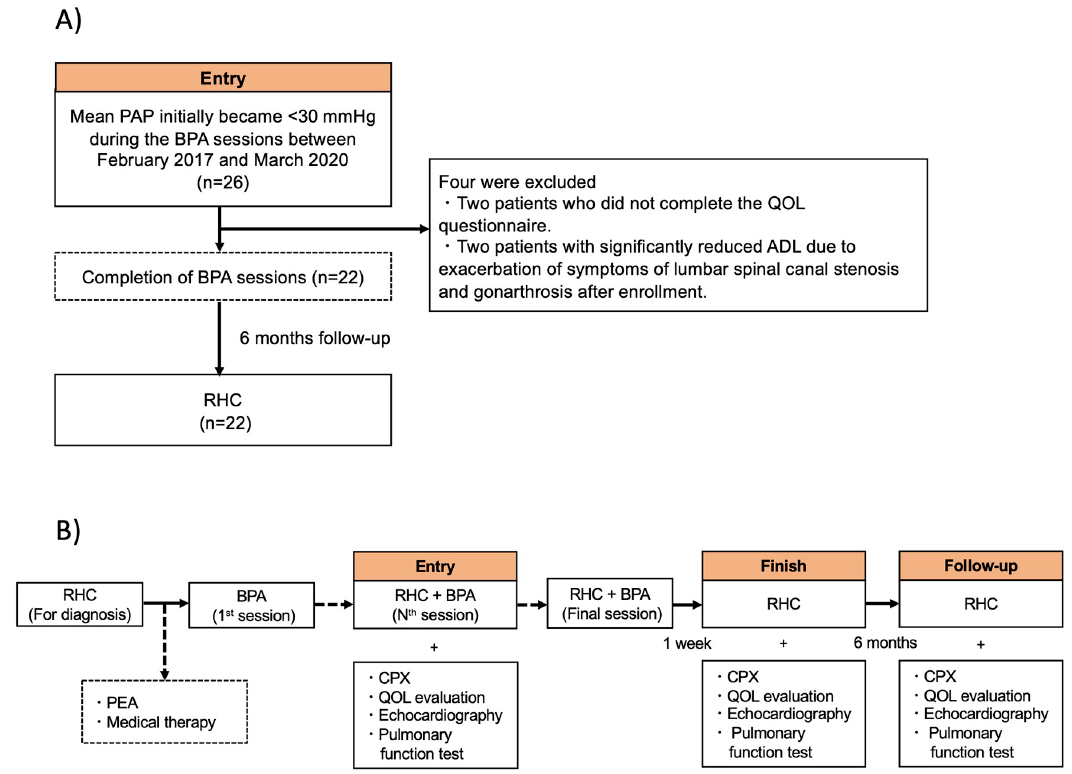
Fig 1. Study flowchart. (A) Patient flowchart. (B) Study design. PAP, pulmonary artery pressure; QOL, quality of life; ADL, activities of daily living; BPA, balloon pulmonary angioplasty; RHC, right heart catheterization; CPX, cardiopulmonary exercise testing; PEA, pulmonary